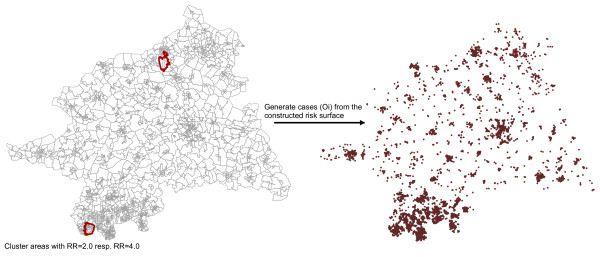
Overview of the simulation process/design. In the defined cluster areas relative risks of two resp. four and in the remaining study a relative risk of one were assigned. The geocoded observed cases (Oi) were generated using an inhomogeneous Poisson process.